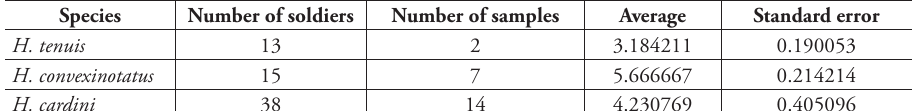
Table 5. Summary statistics for seta counts within a 300-μm radius of the soldier fontanelle.